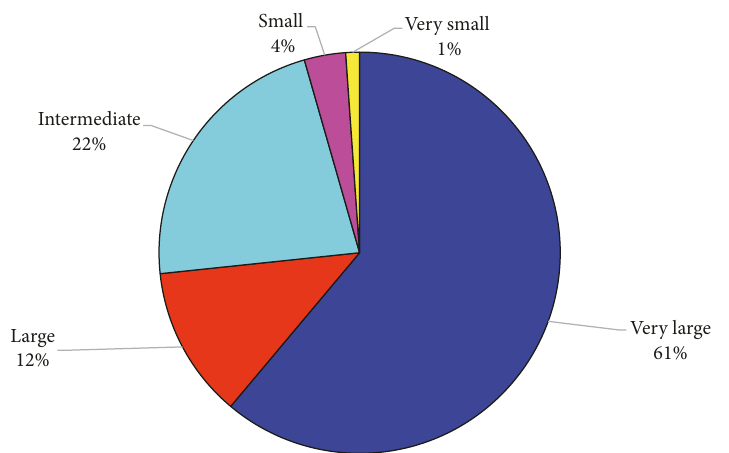
Figure 12: Distribution of ninety-one fresh-market tomato genotypes based on fruit size.